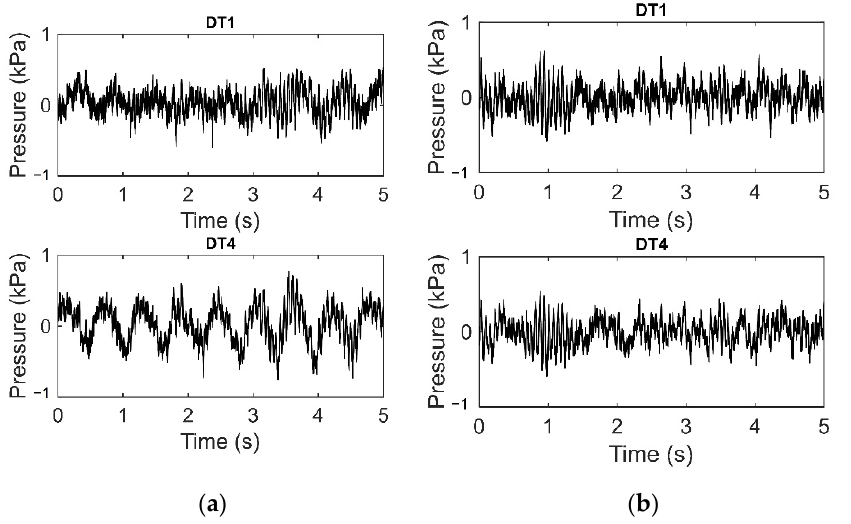
Figure 9. Pressure signals at PL2 operating condition for ( a ) draft tube with no GV and ( b ) with 0 0 GV.